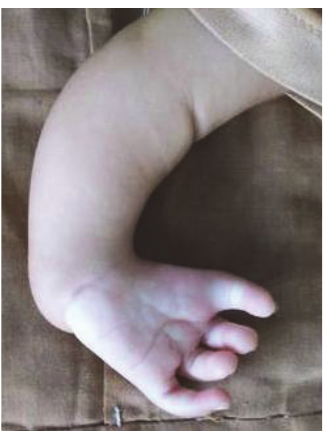
Figure 2: Left upper limb, short left forearm, absent thumb, ulnar deviation at wrist, and contracture of fingers at PIP joint.